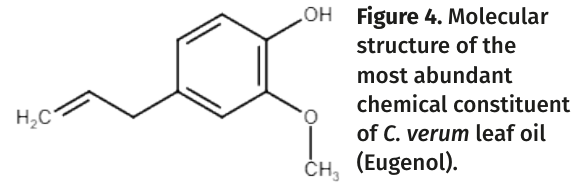
Figure 4. Molecular structure of the most abundant chemical constituent of C. verum leaf oil